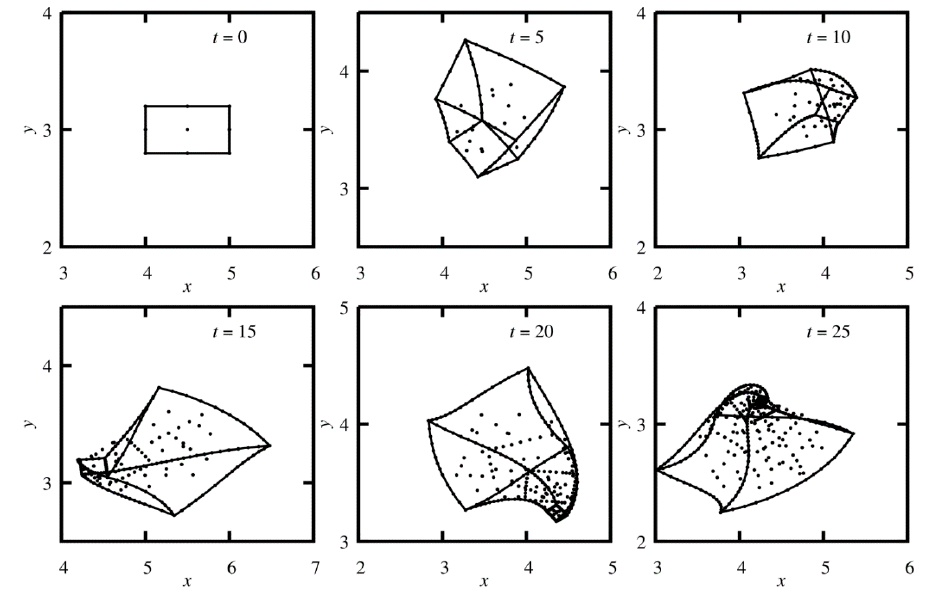
Figure 10. The interval solution of system given by Equation (10) at different times.